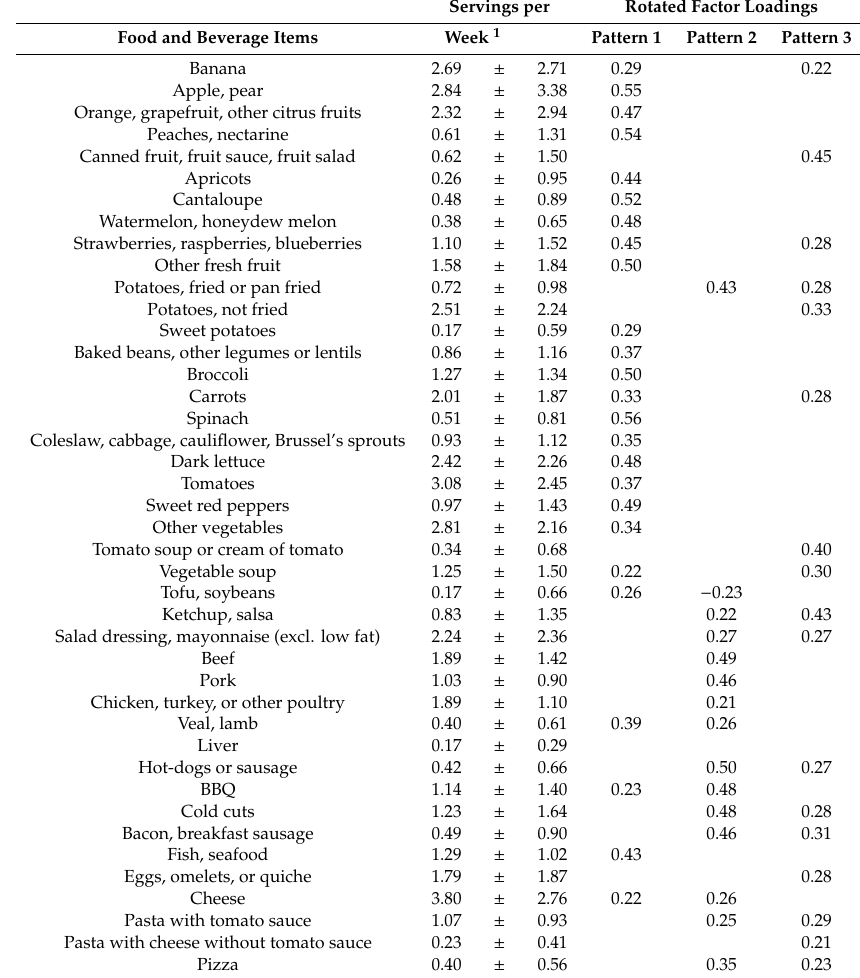
Table 2. Weekly intake of 68 food and beverage items and rotated factor loadings for food and beverage items loadings having absolute values of ≥ 0.2 for any